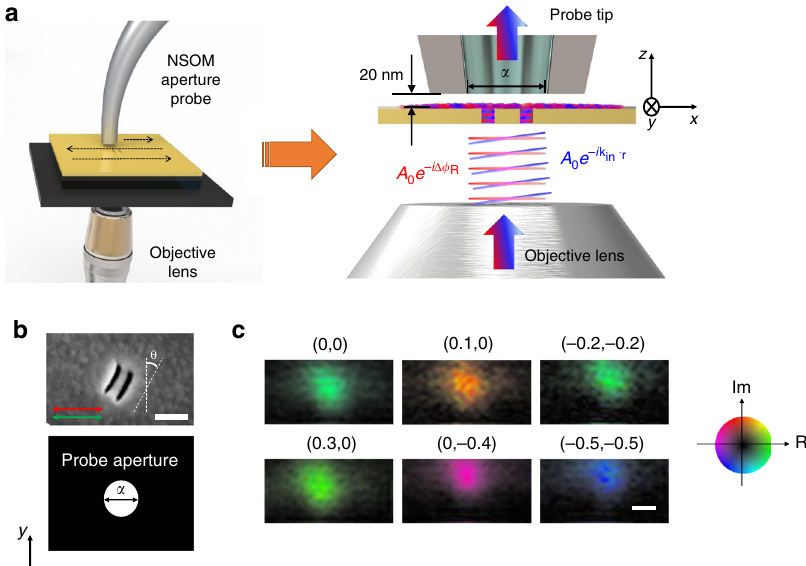
Fig. 1 Experimental recording of a FNTM. a Simpli fi ed experimental schematic diagram. Light waves were introduced from the bottom of the sample through the objective lens, and the aperture-type probe was scanned to obtain near- fi eld maps. For the recording of a FNTM, two planar waves, A 0 e (cid:2) i Δ ϕ R (red lines) and A 0 e (cid:2) i k in (cid:3) r (blue lines), generated by the SLM (not shown) were sent through the objective lens to the bottom of the nano-slits (image on the right). An aperture probe made of a tapered fi ber coated with a gold layer was positioned close to the upper surface. The diameter of the aperture α was 150 nm. The probe converted the interfered near- fi eld wave to the far- fi eld wave, which was then delivered to the photodetector (not shown). b Upper image: scanning electron micrograph of the double nano-slits. Scale bar, 150 nm. The red arrow indicates the polarization of the far- fi eld illumination, and the green arrow shows the polarization of the near- fi eld collection set according to the fi ber probe bending direction. The nano-slits were rotated by θ = 34° clockwise. Lower image: the dimension of the probe aperture used in the experiment. c Complex- fi eld maps of the near- fi eld waves acquired by NSOM for various incident wavevectors, k in . The coordinate above each sub- fi gure indicates k and imaginary values of the near- fi eld